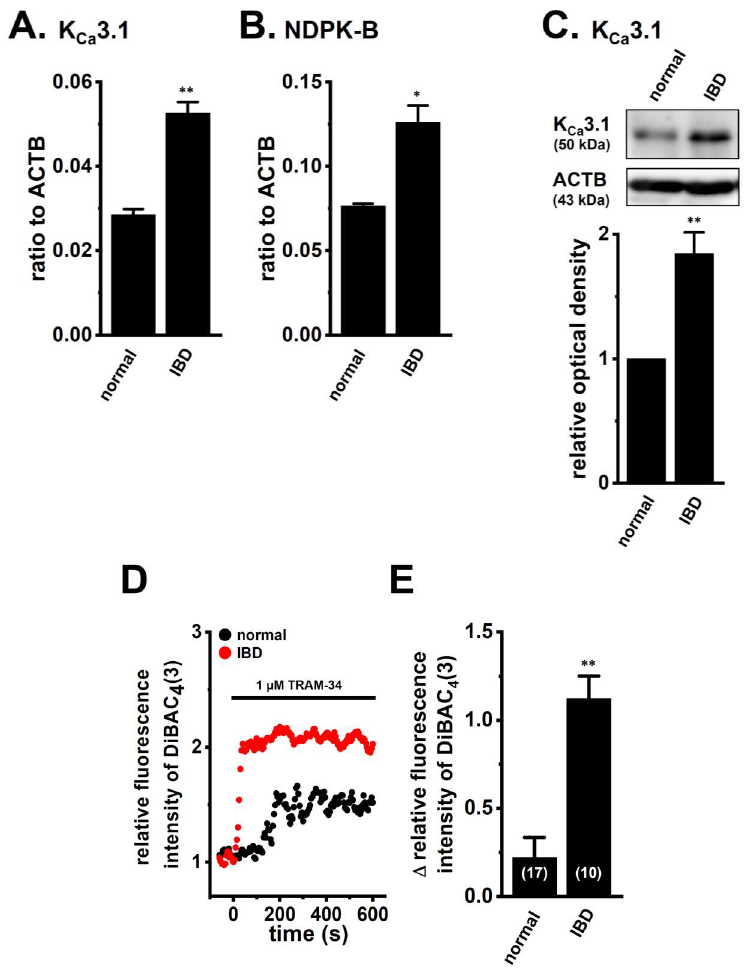
Figure 1. Increase in the expression and activity of K Ca 3.1 in splenic CD4 + T cells of IBD model mice. ( A , B ) Real-time PCR assay for K Ca 3.1 ( A ) and NDPK-B ( B ) in the splenic CD4 + T cells of “normal” and “IBD” model mice ( n = 4 for each). Expression levels were expressed as a ratio to ACTB. ( C ) Expression of K Ca 3.1 proteins (approximately 50 kDa) in the splenic CD4 + T cells of “normal” and “IBD” model mice. Protein lysates of the examined cells were probed by immunoblotting with anti-K Ca 3.1 (upper panel) and anti-ACTB (lower panel) antibodies on the same filter. Summarized results were obtained as the optical density of K Ca 3.1 and ACTB band signals. After compensation for the optical density of the K Ca 3.1 protein band signal with that of the ACTB signal, the K Ca 3.1 signal in “normal” was expressed as 1.0 ( n = 4 for each). ( D ) Voltage-sensitive fluorescent dye imaging of 1 µ M TRAM-34-induced depolarization responses in the splenic CD4 + T cells of normal and IBD model mice. Cells were isolated from three different mice in each group. The cell numbers that were used in the experiments are shown in parentheses. The fluorescent intensity of DiBAC 4 (3) before the application of TRAM-34 at 0 s is expressed as 1.0. Images were measured every 5 s. ( E ) Summarized data are shown as 1 µ M TRAM-34-induced depolarization responses [ ∆ relative fluorescence intensity of DiBAC 4 (3)] in normal and IBD model mice. The values of fluorescent intensity were determined by measuring the average for 1 min (12 images) before quitting the application of 1 µ M TRAM-34. The results are expressed as means ± SEM. *, **: p < 0.05, 0.01 vs. normal mice (normal). AP-1 (Fos/Jun homo-/hetero-dimer), REST, and HDACs are transcriptional and post-